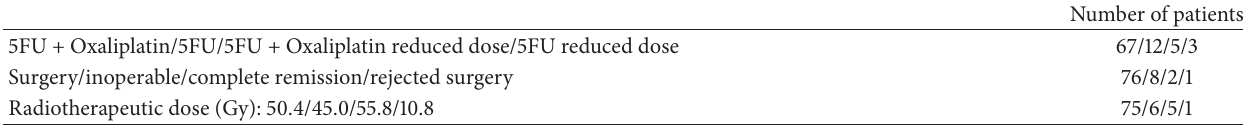
Table 1: Patients treatment by chemotherapy, surgery and